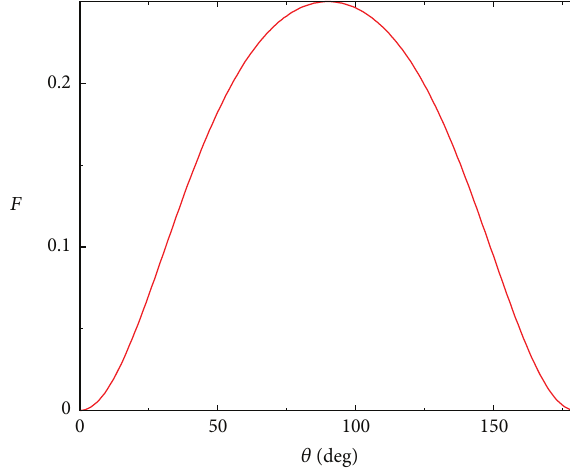
Figure 24: Plot of the spectrum 𝐹 in 𝑉 = 0 limit (F.2), 𝑚 = 1.5 GeV, 𝛽 = 0.5 .